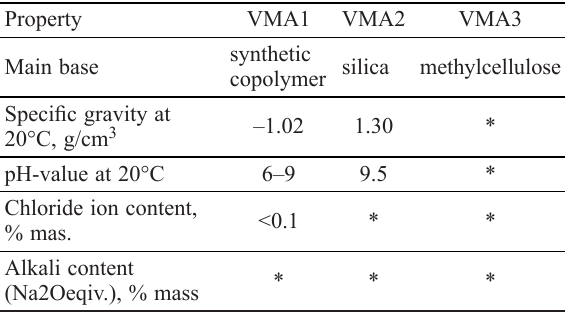
Table 3. The properties of viscosity modifying admixtures Property